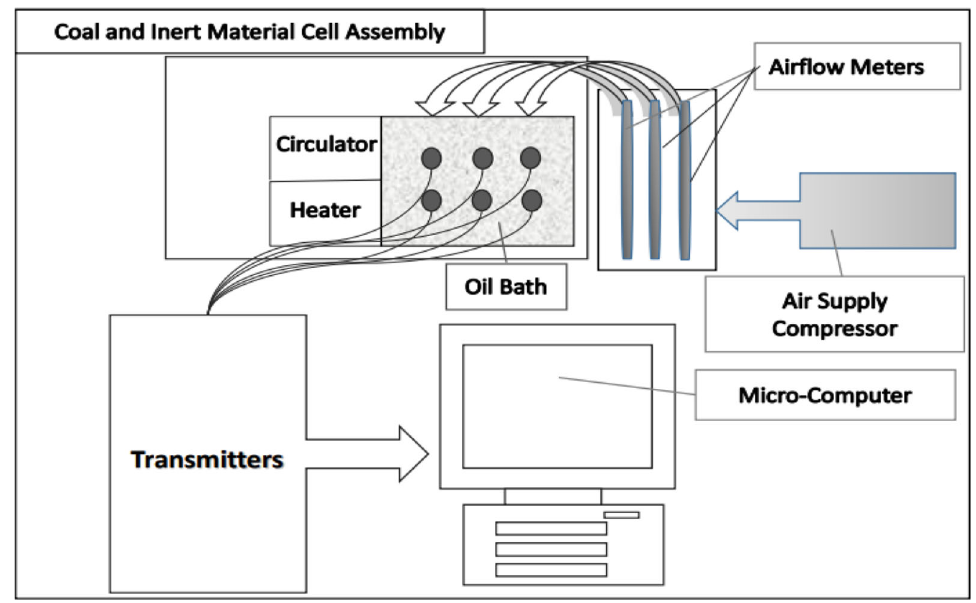
Fig. 3 Representation of the Wits-Ehac equipment (Wade et al.